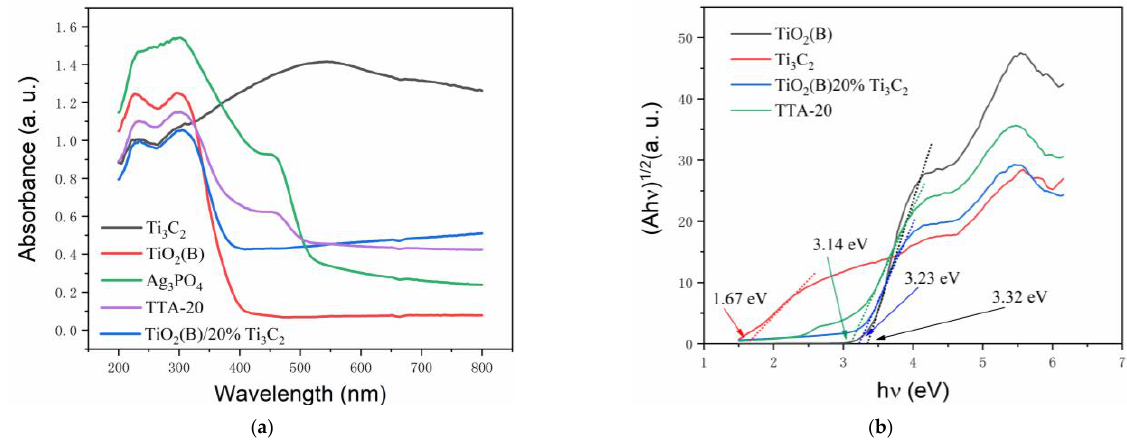
Figure 4. ( a ) Ultraviolet-visible (UV-Vis) absorption spectra and ( b ) band gaps of